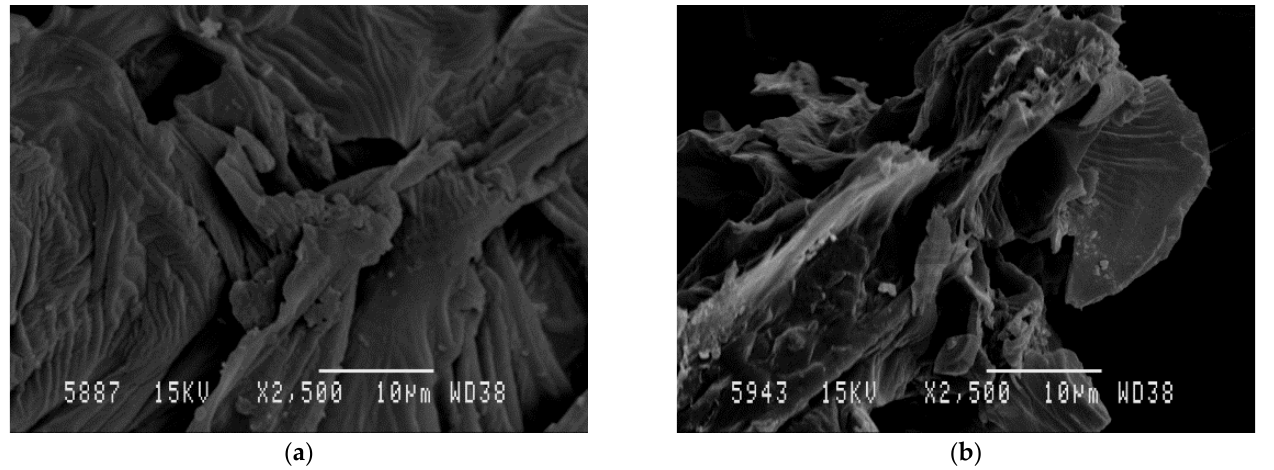
Figure 5. SEM micrographs of raw AVS ( a ) and AVS after MAE under optimal conditions ( b